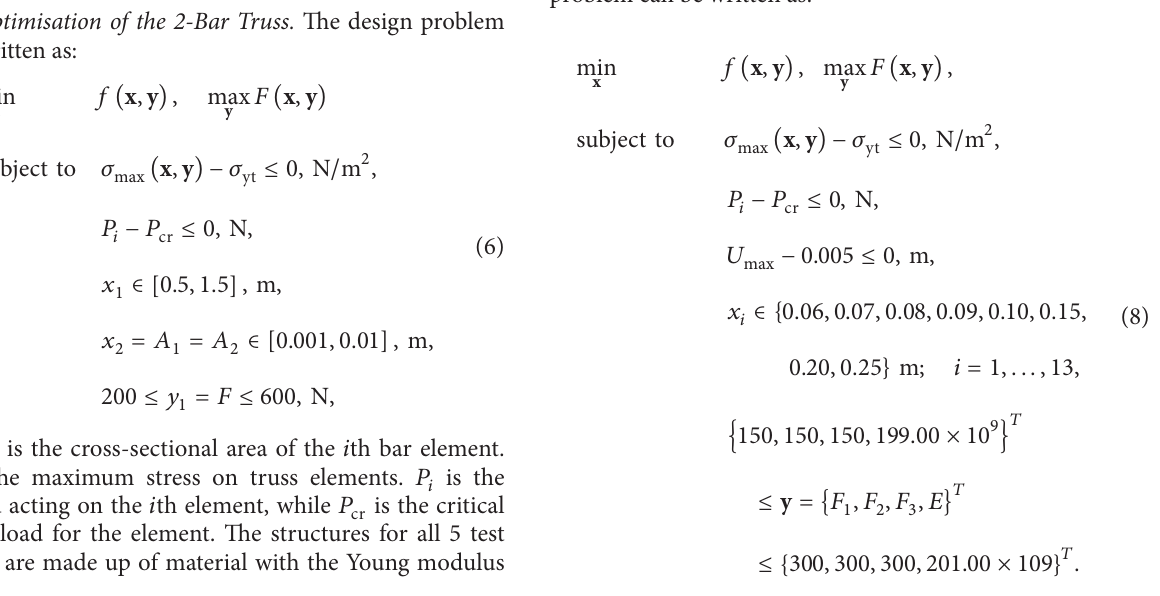
Figure 3: 10-bar